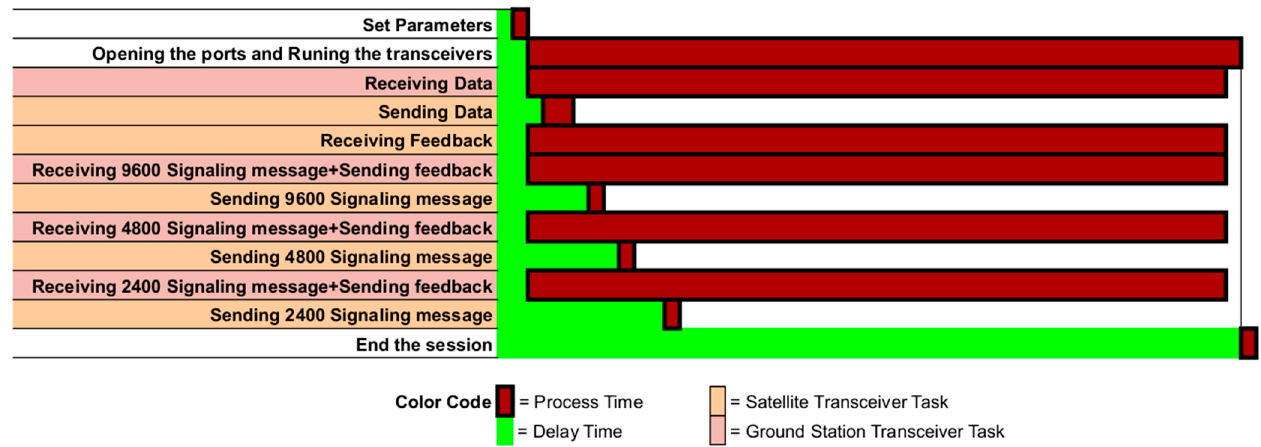
Figure 5. Thread timing and scheduling.